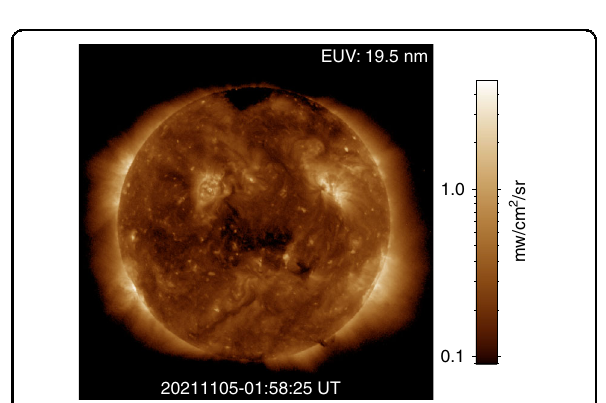
Fig. 3 EUV 19.5 nm image with absolute brightness from X-EUVI. The notes are consistent with Fig.